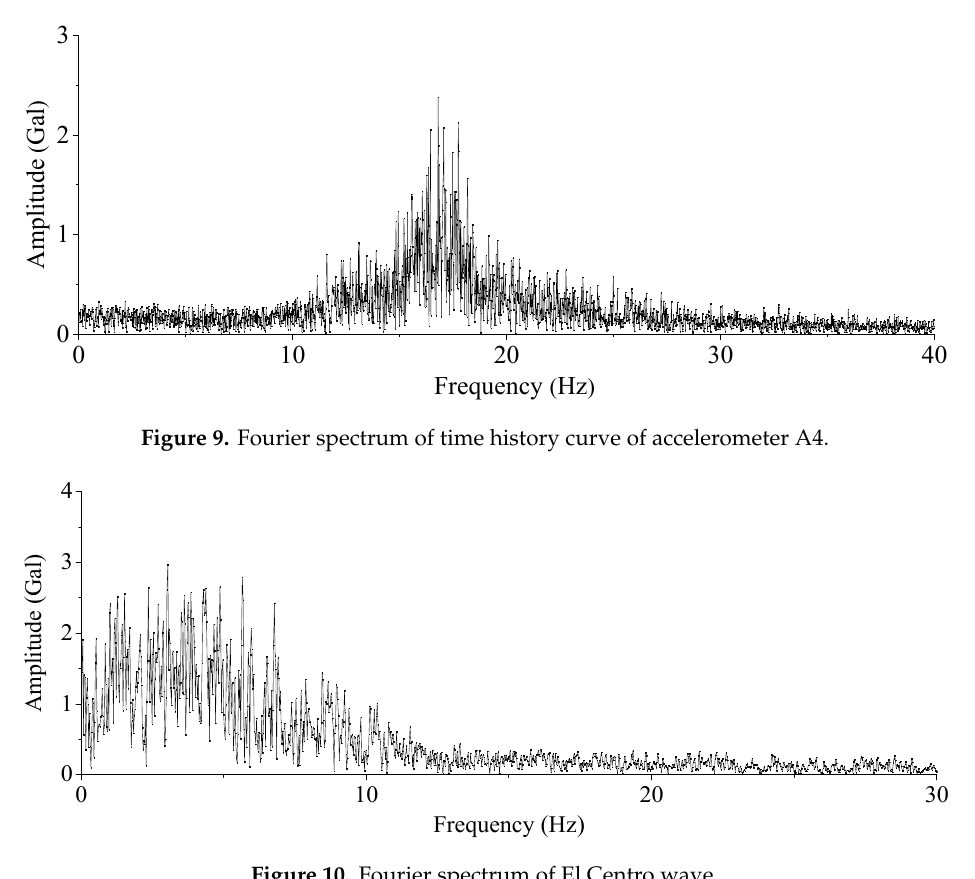
Figure 8. Time history curve of El Centro wave.